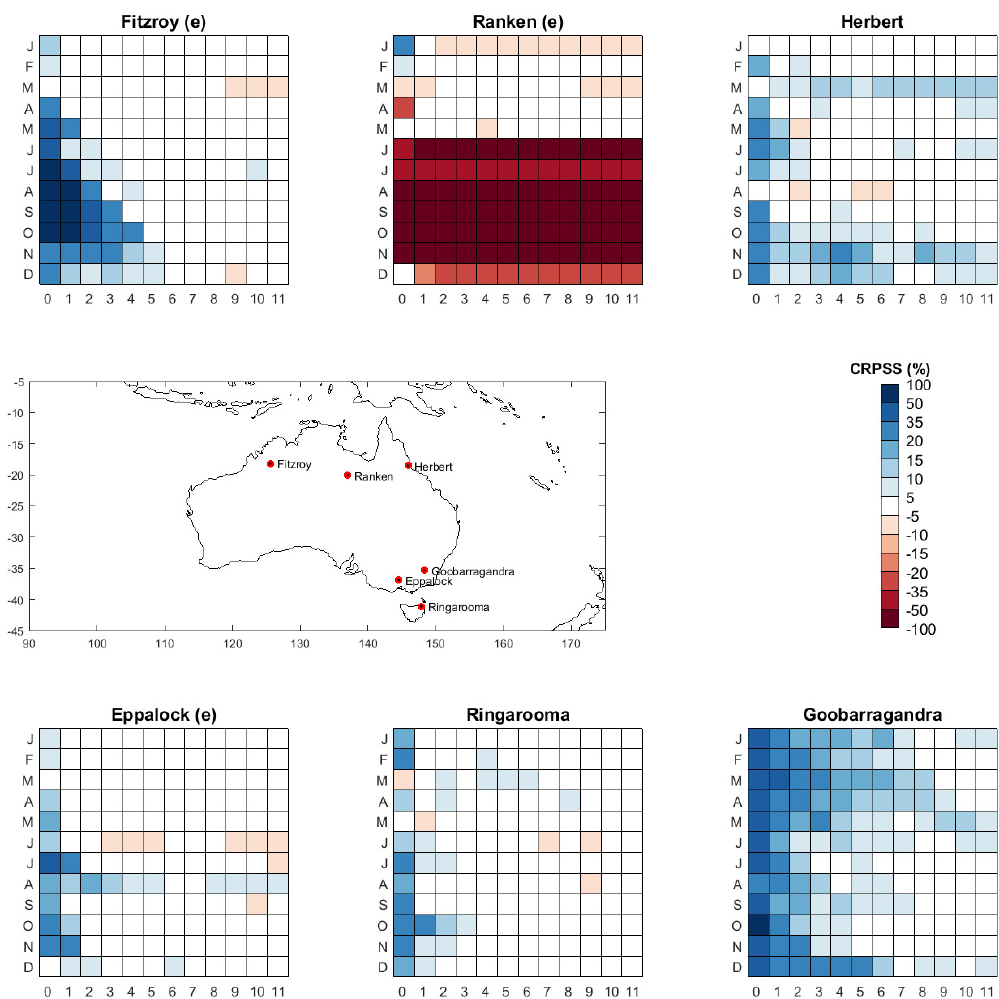
Figure 14. Skill (CRPSS) of FoGSS forecasts generated with the GR2M hydrological model and with a strong prior on the d parameter of σ d = 0 . 25. Ephemeral catchments are denoted by (e). Target months are shown on the vertical axes, and target lead times on the horizontal axes. Centre map gives catchment